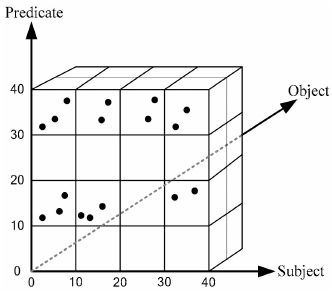
Figure 5. Extended RDF tuples in the three-dimensional